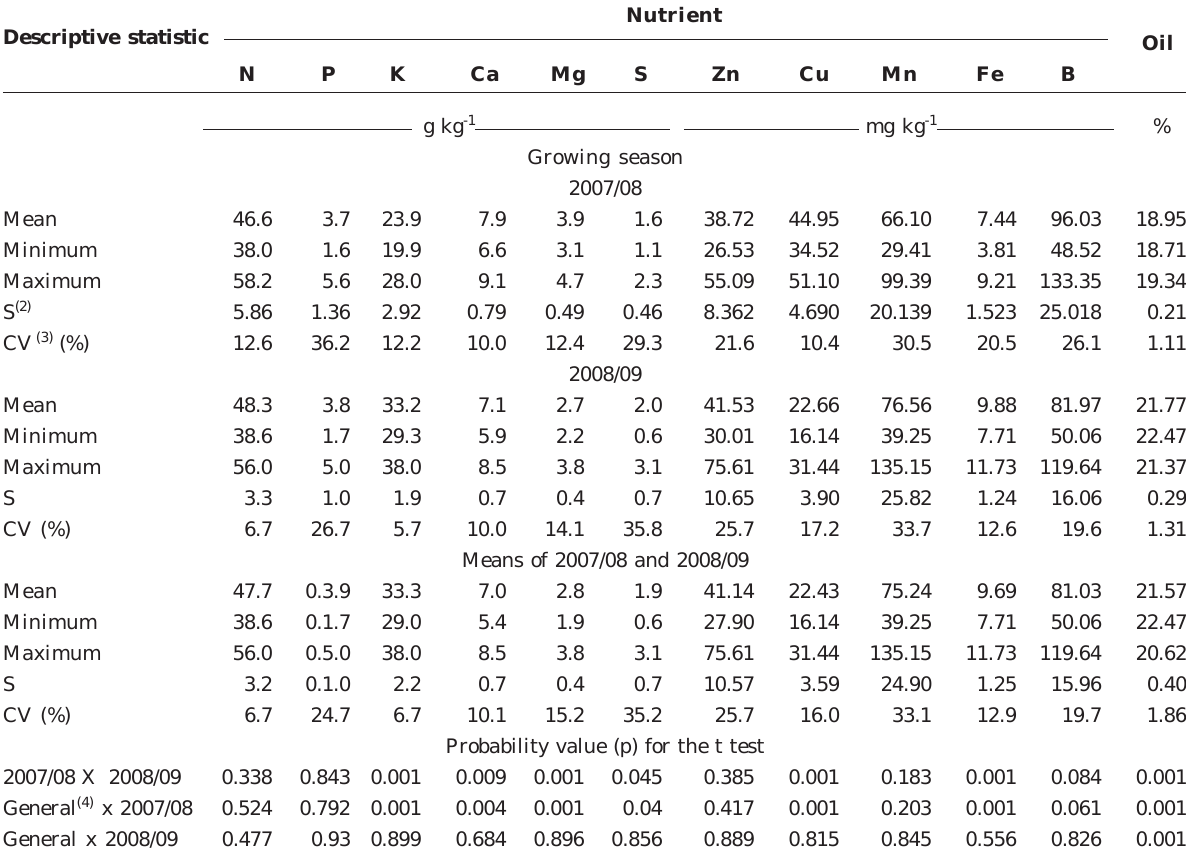
Table 1. Descriptive statistics of leaf nutrient contents in soybean (R2 stage) with high (1) oil content, based on data of the 2007/08 and 2008/09 growing seasons and the means of these